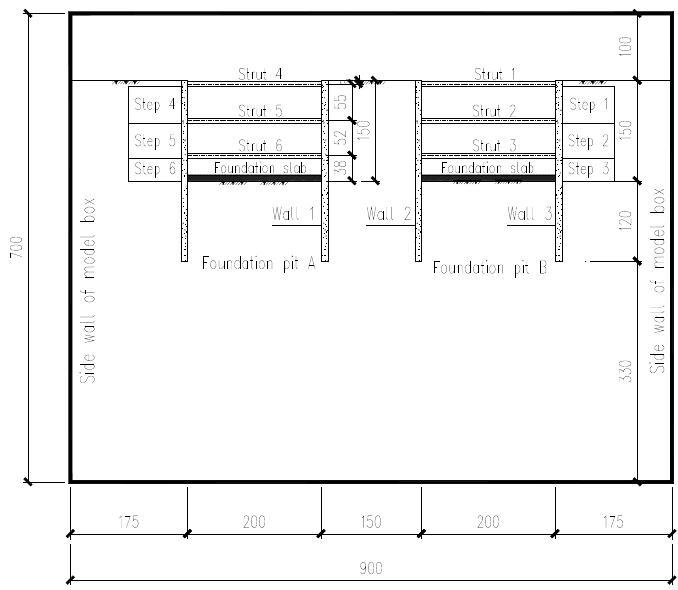
Figure 2. Model test section.